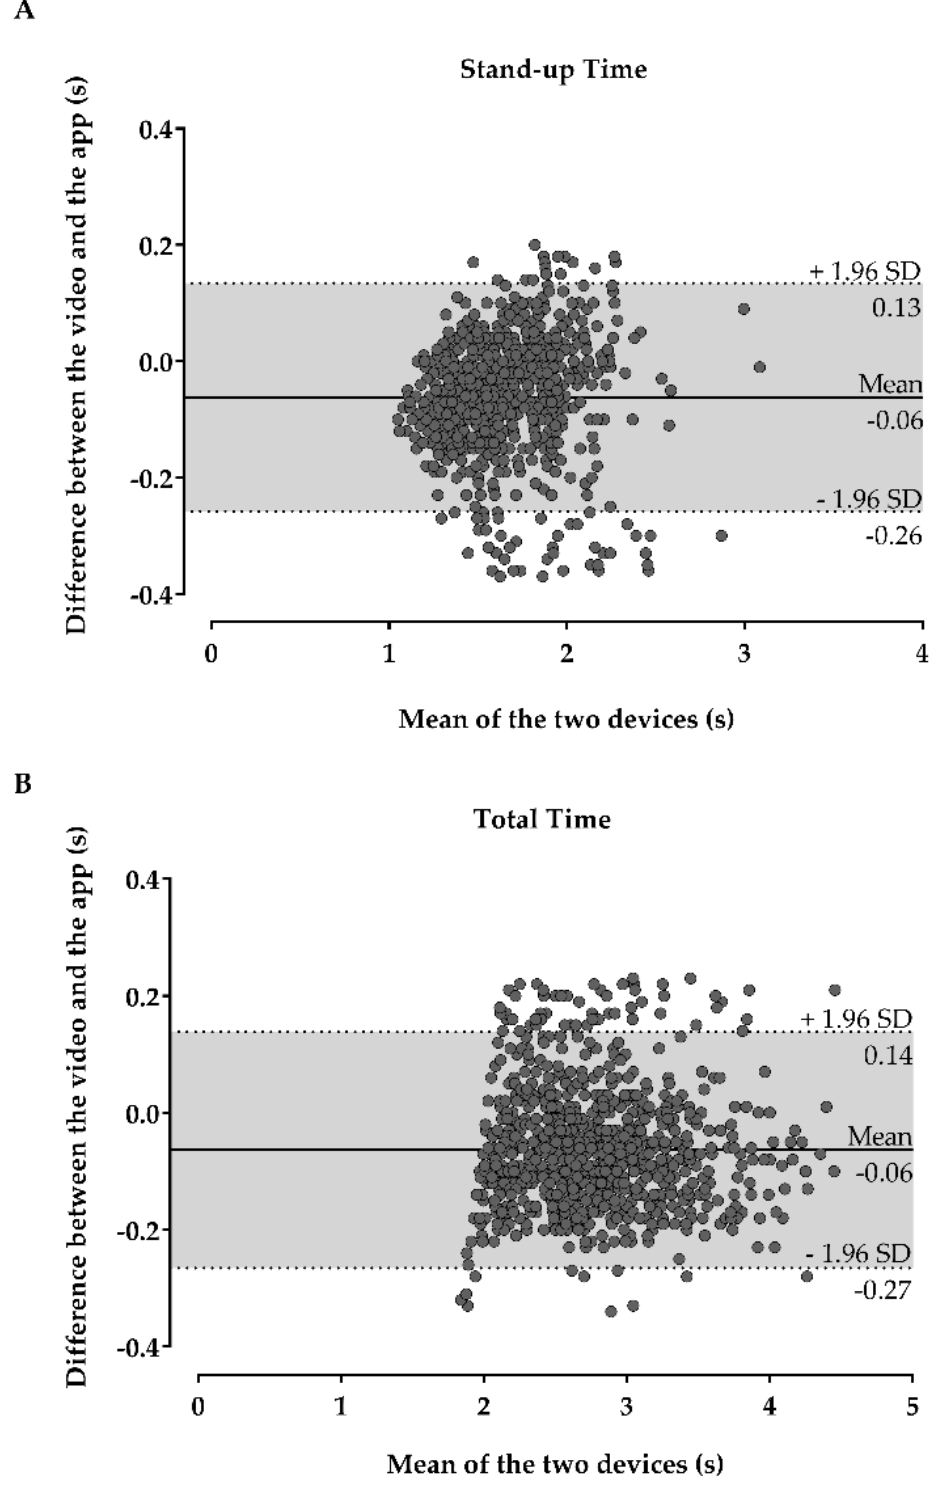
Figure 3. Bland-Altman plots with 95% limits of agreement (mean difference ± 1.96 × standard deviation [SD] of the differences) between the mobile application and video-camera for the stand-up time ( A ) and total time ( B ); the solid lines in the middle of the plots represent the mean difference/bias, while the upper and lower dotted lines represent the upper and lower LOA.